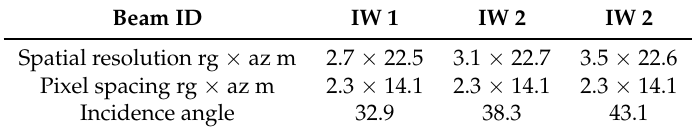
Table 2. Properties of different sub-swath of Level-1 Interferometric Wide SLC product.